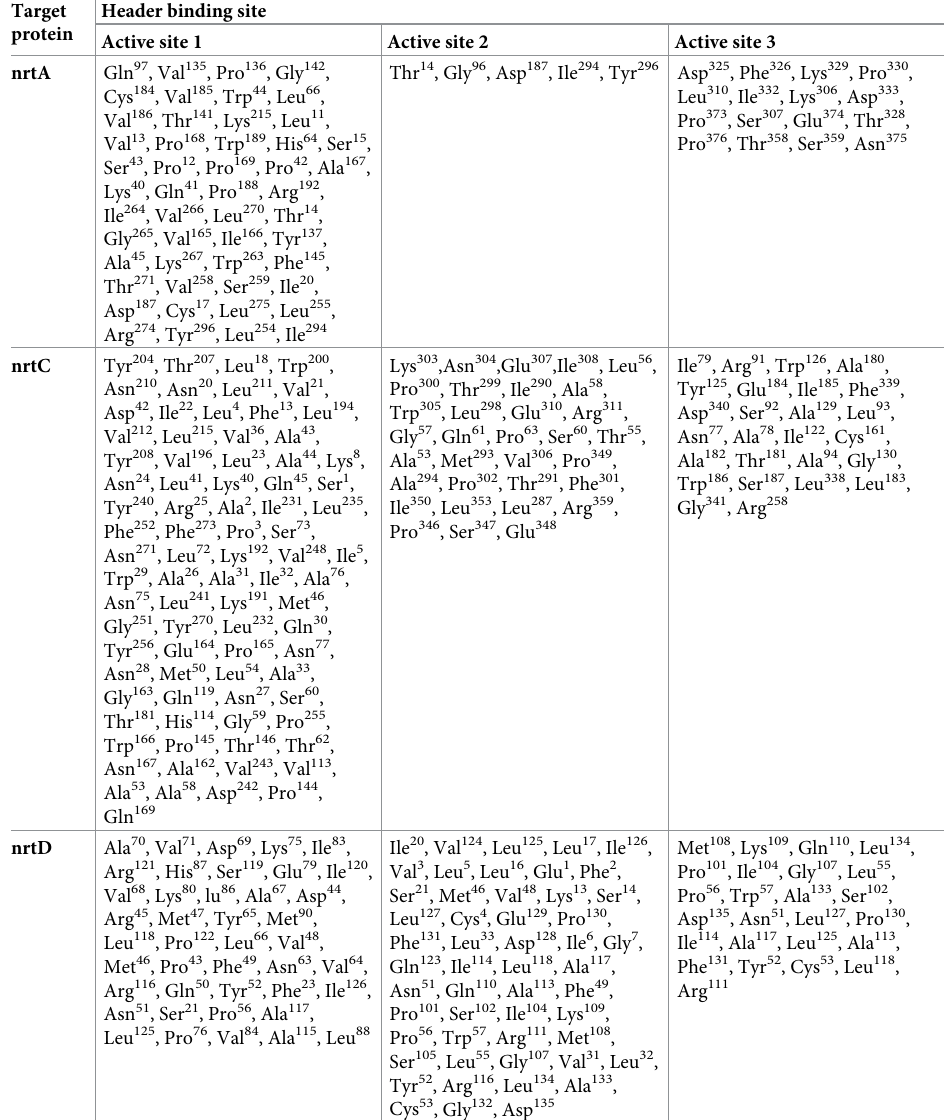
Table 2. The potential ligand binding catalytic active sites of target proteins (nrtACD) calculated with META- POCKET server to perform molecular docking. Target protein